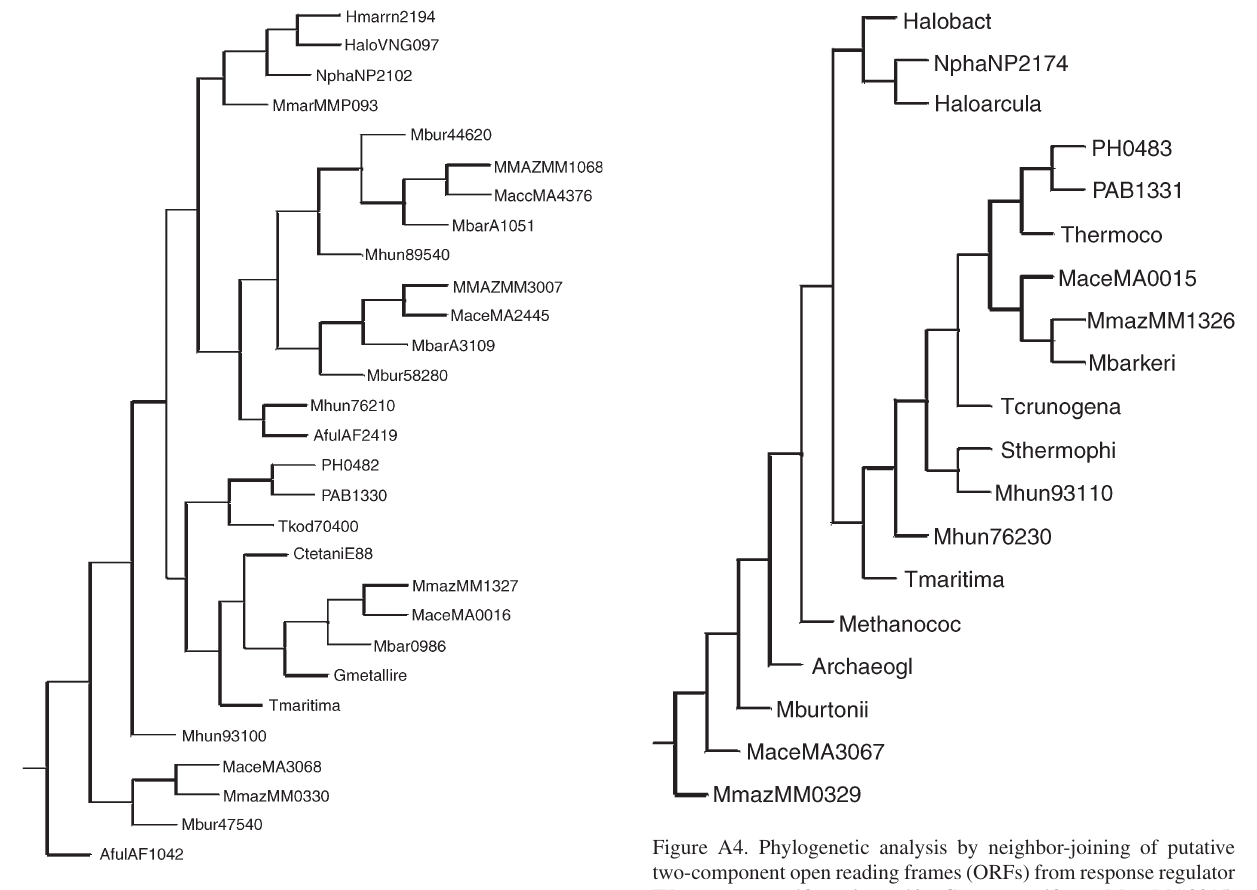
Figure A3. Phylogenetic analysis by neighbor-joining of putative two-component open reading frames (ORFs) from response regula- tor I groups arr7 , arr10 , arr12 and arr14 . Group arr7 = HaloVNG0974G, AfulAF1042, MmarMMP0933, Mbur_401647540, MaceMA3068, MmazMM0330, PAB1330, PH0482, HmarrnAC2194, Tkod_610170400, Mhun_401793100 and NphaNP2102A; group arr10 = MaceMA0016, MbarA_0986 and MmazMM1327; group arr12 = MaceMA4376, MbarA_1051, MmazMM1068, AfulAF2419, Mbur_401644620 and Mhun_401789540; and group arr14 = MaceMA2445, MbarA_3109, MMAZMM3007, Mbur_401658280 and Mhun_401776210. The bacterial ORFs are CtetaniE88, Tmaritima and Gmetallired. Abbreviations: CtetaniE88 = C. te- tani E88_1817150; Tmaritima = T. maritima MSB8_24050; and Gmetallired = G. metallireducens _401349760.